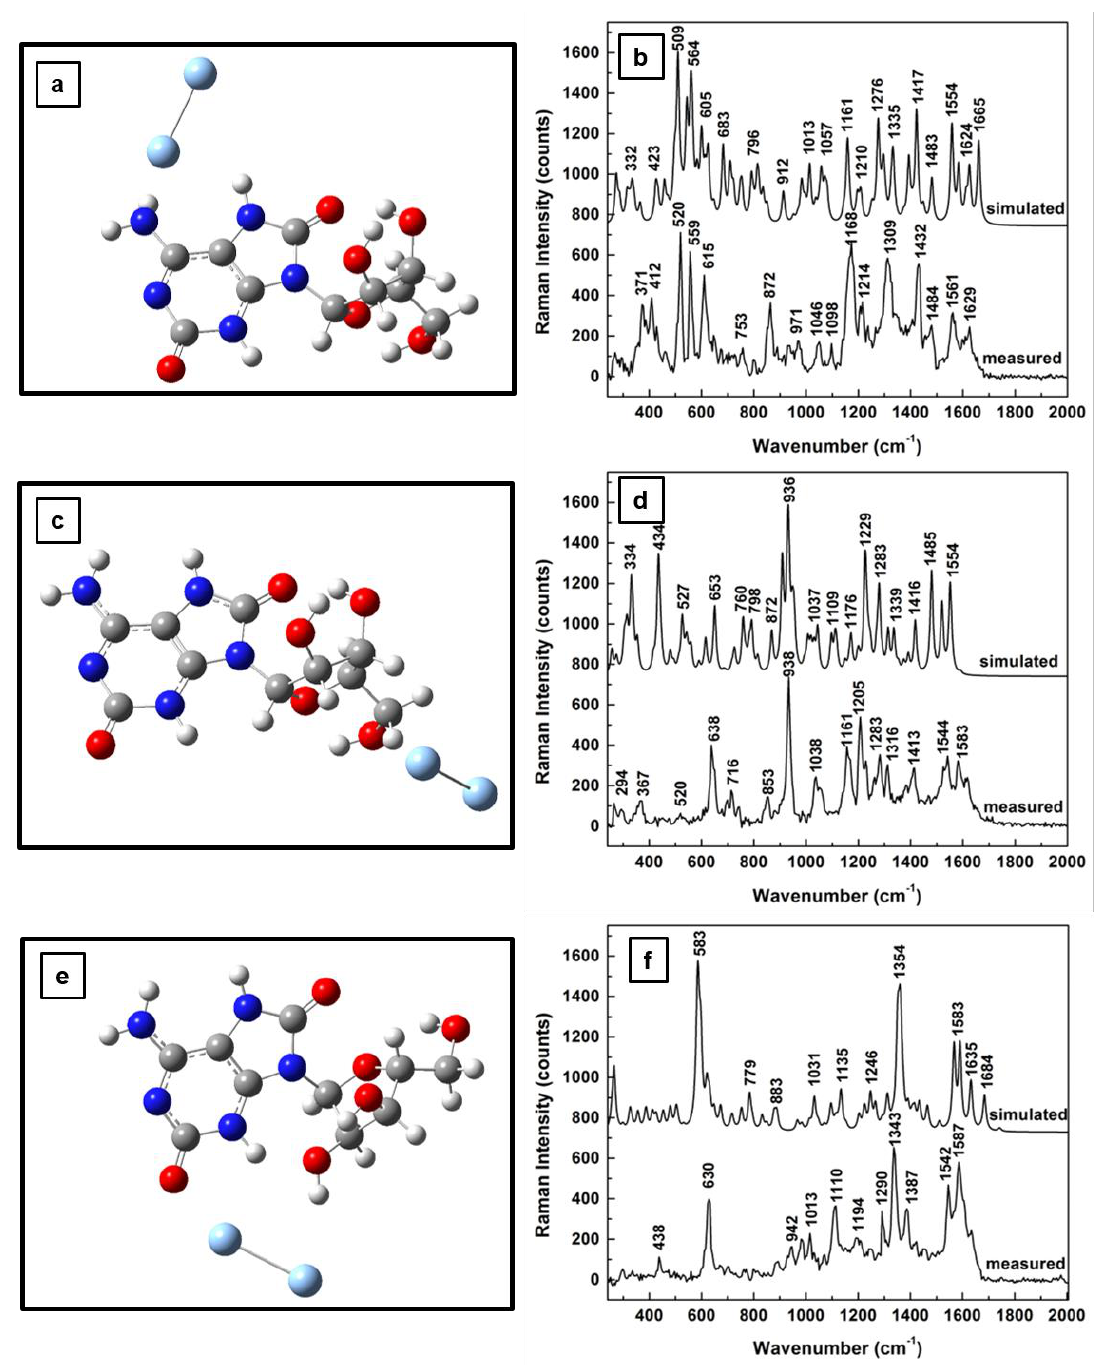
Figure 5. Structural representations of the second step of 2-electron oxidation of adenosine in the proximity of a silver dimer: ( a ) dimer in the proximity of NH 2 site of adenine ring, ( c ) dimer in the vicinity of carbinol moiety, and ( e ) dimer between the C=O and OH chemical bonds of the adenine and ribose structural units, respectively. ( b , d , f ) Theoretically estimated and experimentally recorded Raman vibrational spectra associated with ( a , c , e ), respectively. The spectra are vertically translated for easier visualization and appropriately